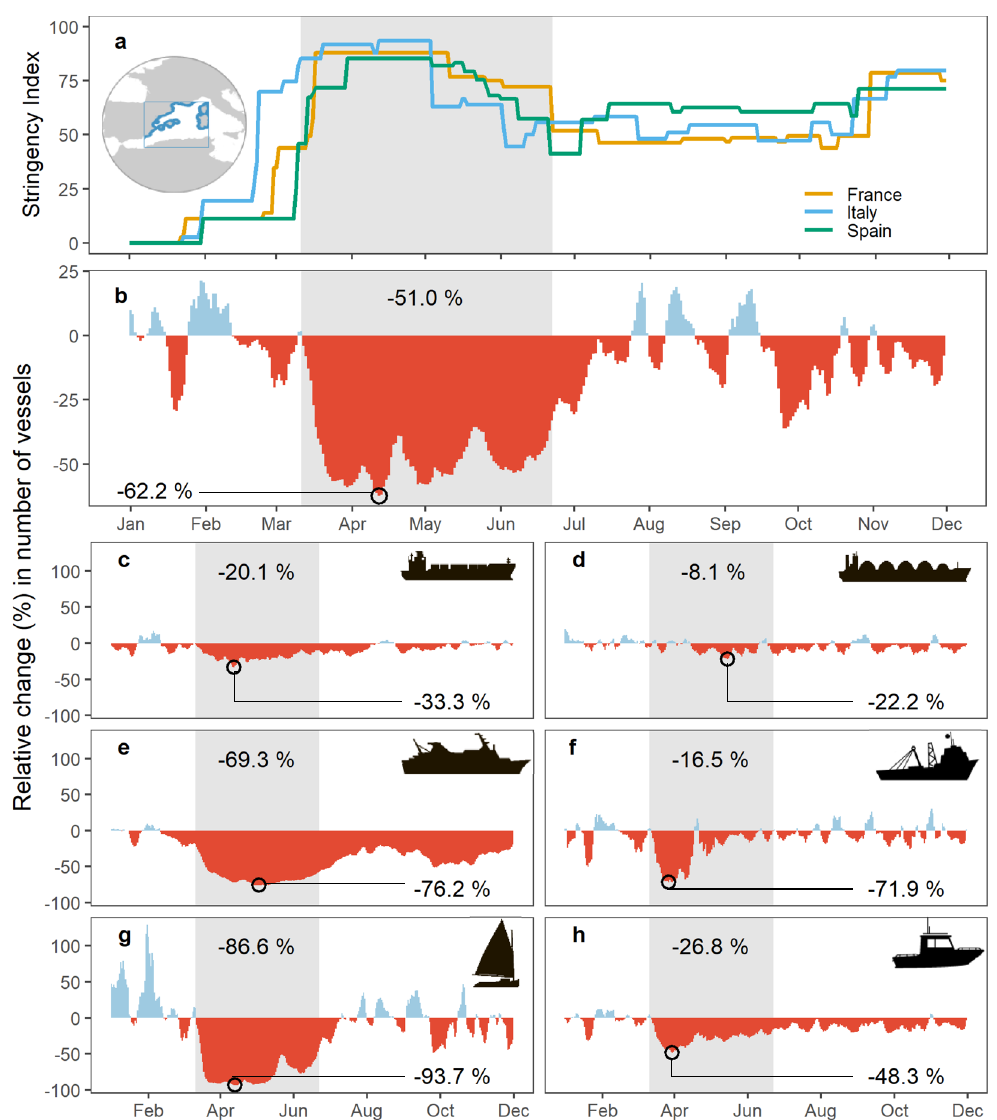
Fig. 8 Daily relative change in number of vessels equipped with Automatic Identi fi cation System (AIS) transponders between 2020 and 2019 in the Western Mediterranean. a Daily changes in the Stringency Index (100 = strictest response) as an indicator of con fi nement measures for EU countries present in the study area (i.e., Spain, France, Italy). b – h Relative change of daily number of vessels underway within the coastal zone (24 nautical miles) present in the study area per vessel category: b All vessel types, c cargo, d tanker, e passenger, f fi shing, g recreational and h others. Increases and decreases in number of vessels are coloured in blue and red, respectively. Daily estimates using 7-day moving average (from 1st January to 30th November). The shaded area in grey highlights the period between the World Health Organization pandemic declaration on 11 March 2020 and 22 June 2020, when EU countries relaxed their con fi nement measures after the fi rst wave. Values within the shaded area represent the median relative change during that period. Circles indicate maximal changes. Blue area in the map inset on part ( a ) represents the spatial extent of the regional AIS using zonal statistics (i.e. average and standard deviation at regular intervals). Moreover, we conducted an estimation of expected occupancy for 2020 based on the last 10 years of ship density estimates from altimetry data 50 (See Supplemen- tary Methods). In addition, we estimated density changes at 10 maritime chokepoints 41,42 . For each chokepoint, we de fi ned a buffer of 0.5 degrees and estimated their mean and standard deviation of the absolute change in traf fi c density on a monthly basis. At a regional level (i.e. Western Mediterranean), we compared the unique number of vessels on a daily basis using T-AIS. Our dataset showed a marked annual cycle, reducing in the boreal winter and a year on year increasing annual trend for some sectors (Supplementary Fig. 6), hence we compared the 2020 values (since 1st January to account for changes from early in the development of the pandemic) with the same periods of 2019. In order to take into account the dynamics of ship-based activities through time, the comparison between the datasets of the 2 years was adjusted so the same days of the week were being compared and to allow for the extra day in 2020, being a leap year. We calculated a 7-day moving average and then estimated the relative percentage change.